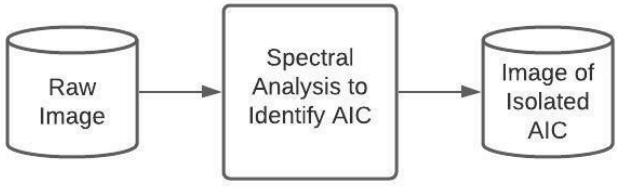
Figure 2. Abridged Method for Hyperspectral Analysis of AIC. Image preprocessing and analysis were completed with the Imagery Analysis Remote Sensing Tool, L3 Harris ENVI Classic version